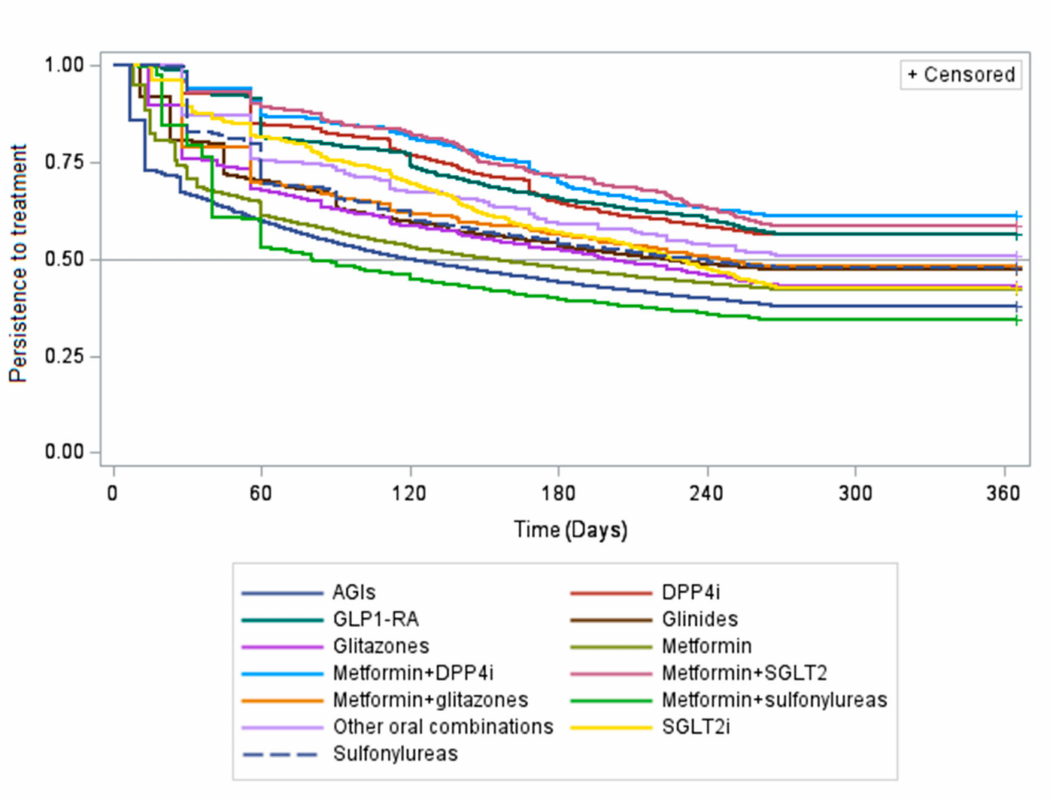
Figure 5. Time to discontinuation of AD treatment during the first year among incident treatments, stratified by antidiabetic molecule / class. Legend: AGI = alpha-glucosidase inhibitors; DPP4i = dipeptidyl peptidase-4 inhibitors; GLP-1RA = glucagon-like peptide-1 receptor antagonists; SGLT2i = sodium–glucose linked transporter 2 inhibitors; Other oral combinations = fixed-dose combinations of glitazones + DPP4i and glitazones +